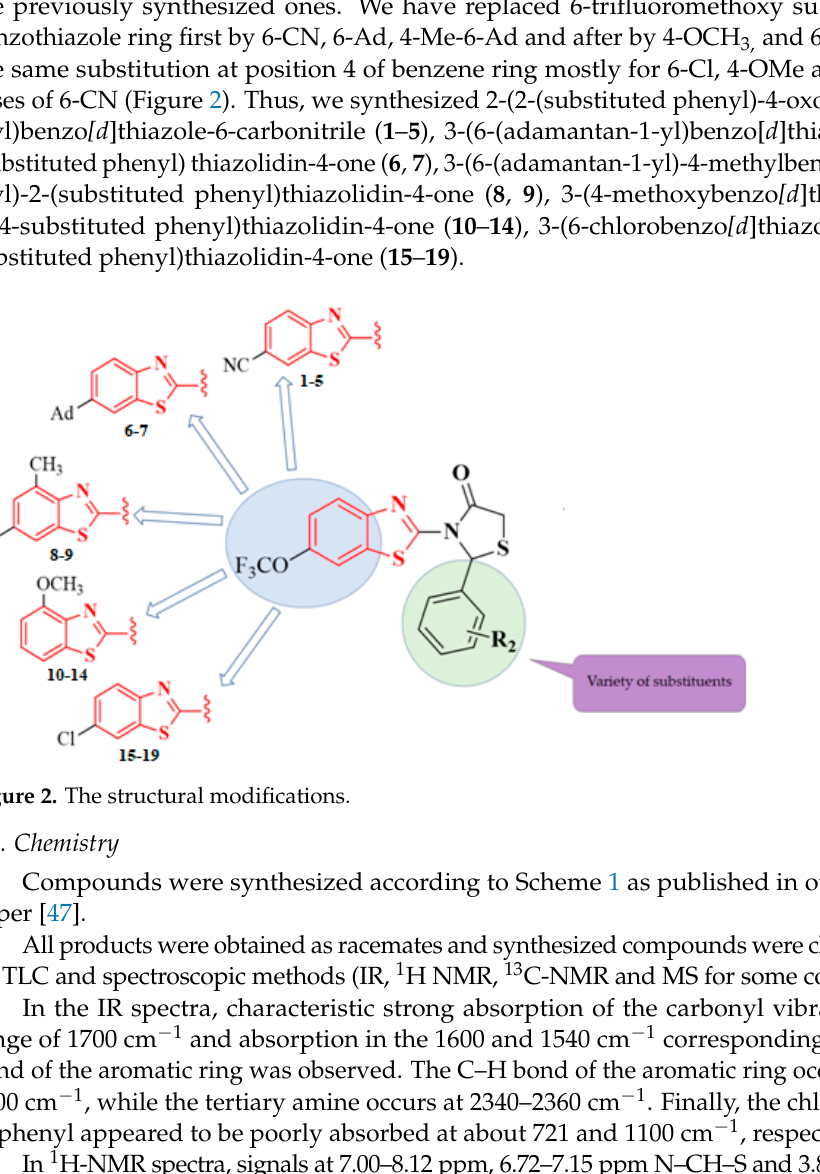
Figure 1. Drugs approved by FDA.